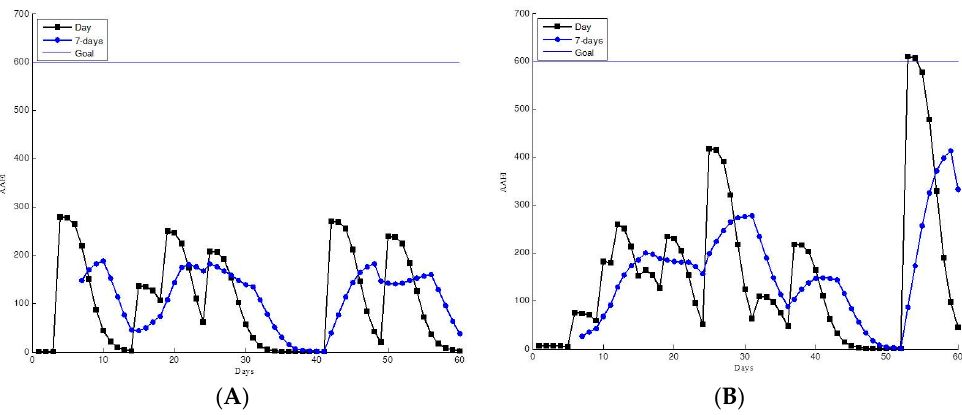
Figure 10. Participants with insufficient AAEI values, as determined in the 60-day trial. ( A , B ) AAEI values indicating insufficient activity but with occasional exercise.